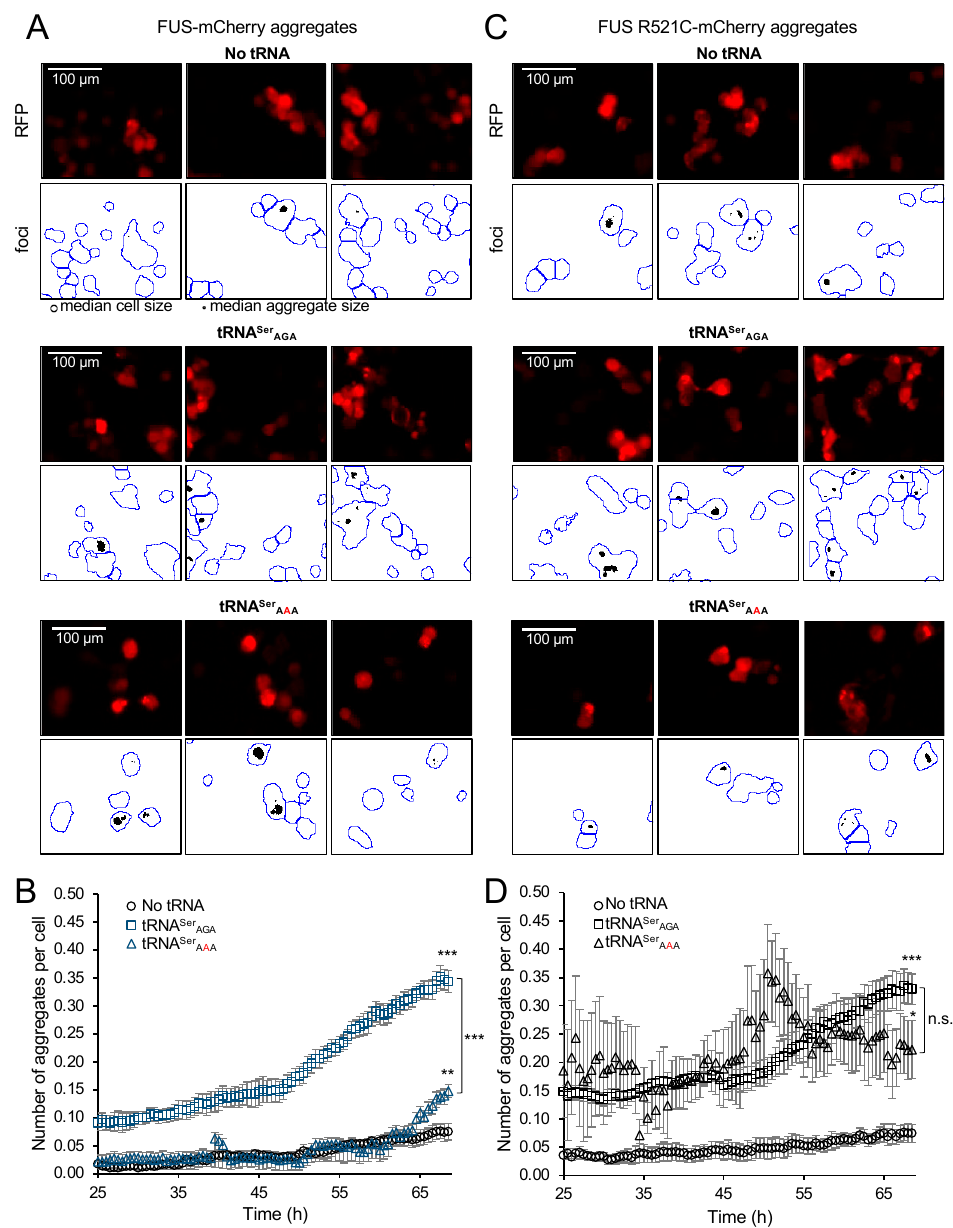
0.000.050.100.150.200.250.300.350.400.450.50 Figure 6. Mistranslation modifies the aggregation kinetics of FUS and FUS R521C in N2a cells. The number of FUS aggregates per cell was quantified at each time point. N2a cells were transfected with a plasmid encoding no tRNA, human tRNA SerAGA , or tRNA SerAAA and ( A , B ) FUS-mCherry or ( C , D ) FUS R521C-mCherry. Representative images (see Figures S7 and S8) were captured by live-cell fluorescence microscopy (RFP ex. 531 nm, em. 593 nm) for 43.5 h time course. Fluorescent cell area representing cells and aggregates was determined using a custom Fiji/ImageJ macro (see Supplementary Information). Cell and aggregate counts were determined based on the observed median cell and aggregate area. ( A , C ) Representative images of the fluorescing cells and black and white mask images showing aggregate area (black) and cell area (blue outlines). ( B , D ) The number of aggregates per cell was plotted over time. Error bars represent the mean ± 1 standard deviation of at least four biological replicates. Significant differences (see also Figure S6) based on pairwise independent sample t -tests are indicated (* p < 0.05, ** p < 0.01, *** p < 0.001) and annotated above the final time point in comparison to the no tRNA control and between AAA/AGA by